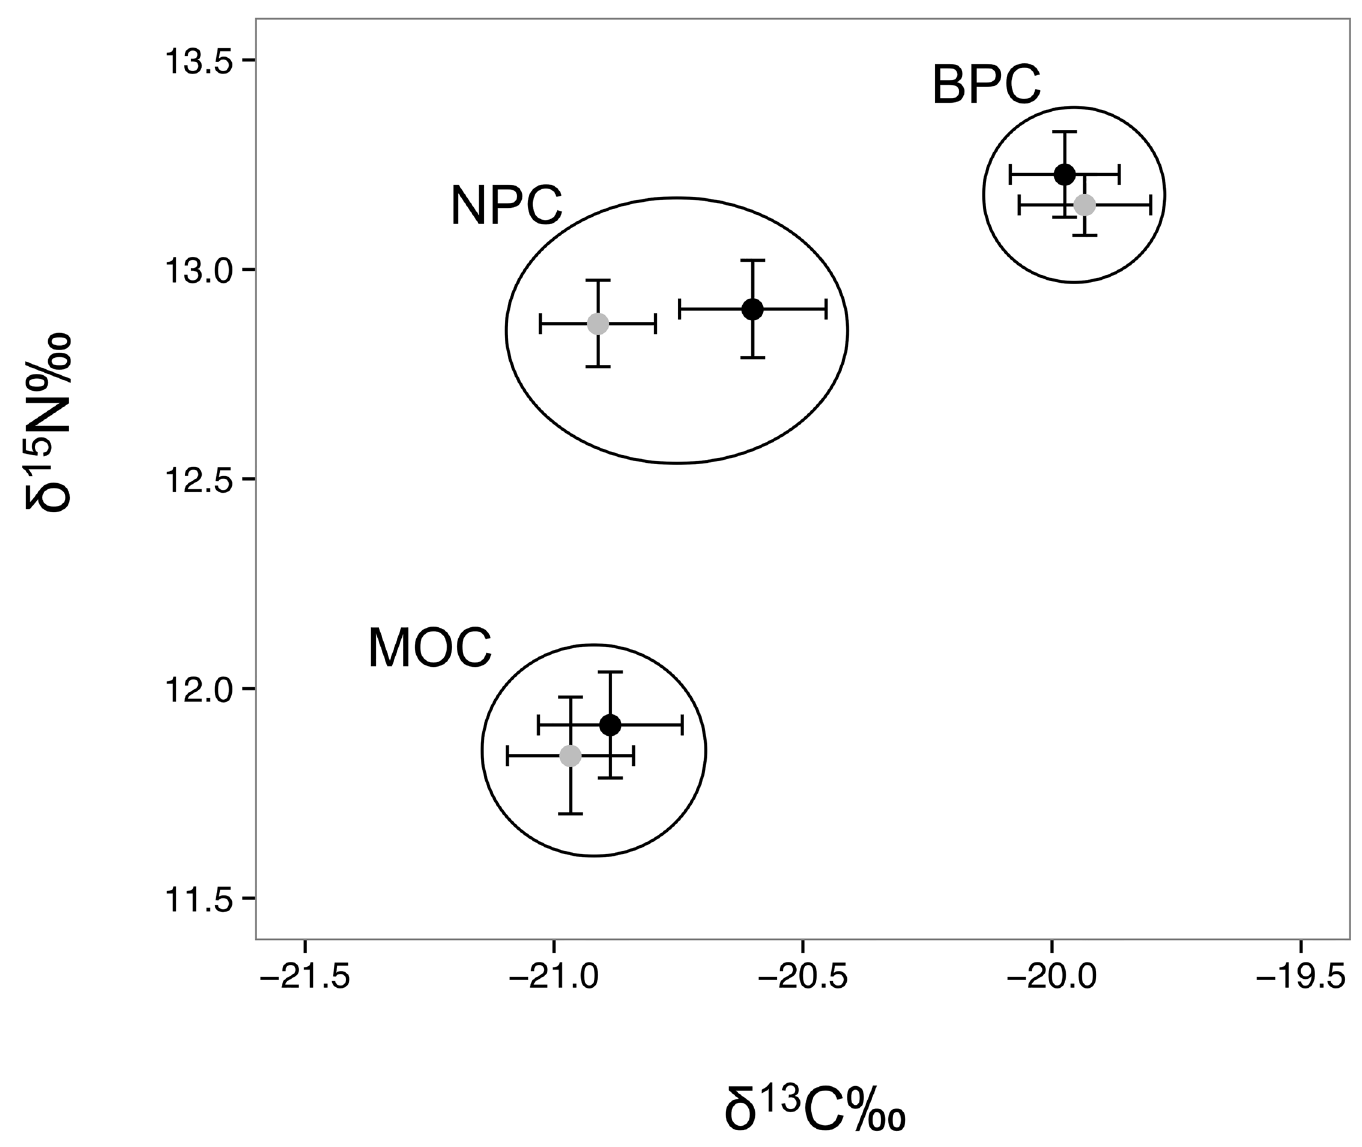
Fig 5. Stable isotope values (fractionation adjusted) of murres according to sex and stage. δ 15 N ‰ and δ 13 C ‰ (mean ± SE) values of blood (BPC; n = 65), secondary covert (MOC; n = 75) and breast (NPC; n = 78) feathers of female (grey) and male (black)